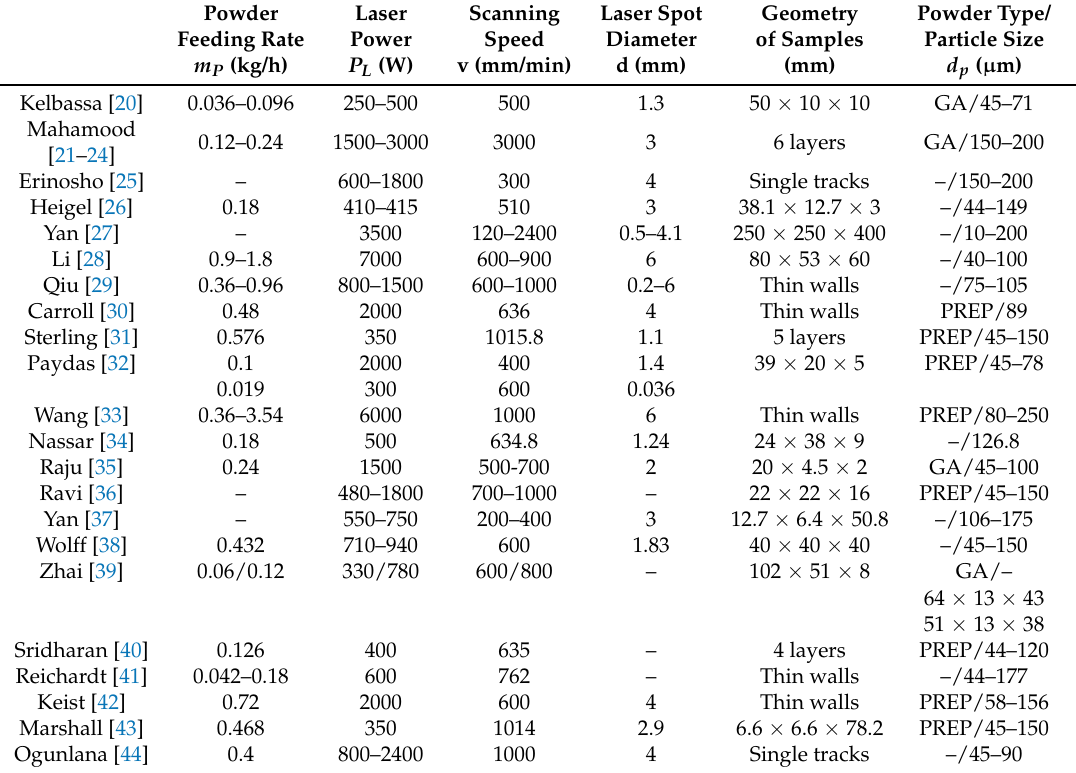
Table 3. Process windows of laser metal deposition (LMD) of